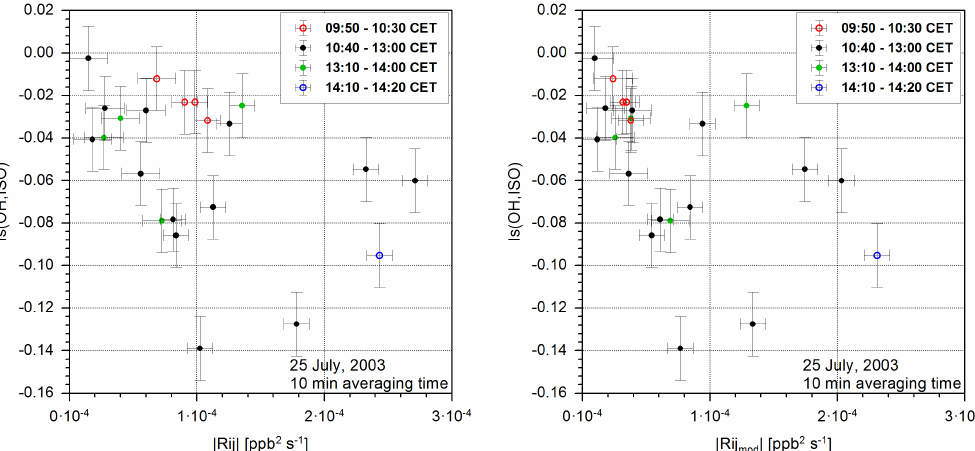
Figure 14. The intensity of segregation as a function of R ij and R ij